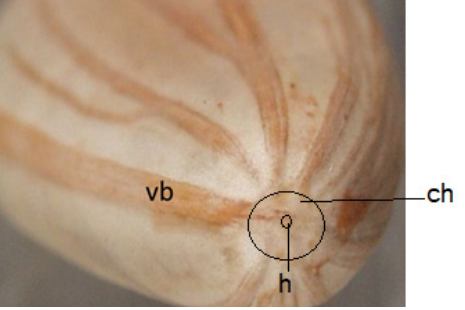
Fig. 4: Vascular bundles (vb) in the testa of a depulped seed. The vascular bundles approach, but are not continuous at the chalaza (ch). The hypostasis (h) at the center of the chalaza is not clearly to be seen. The micropyle is at the opposite end of the seed. Scanning electron microscopy